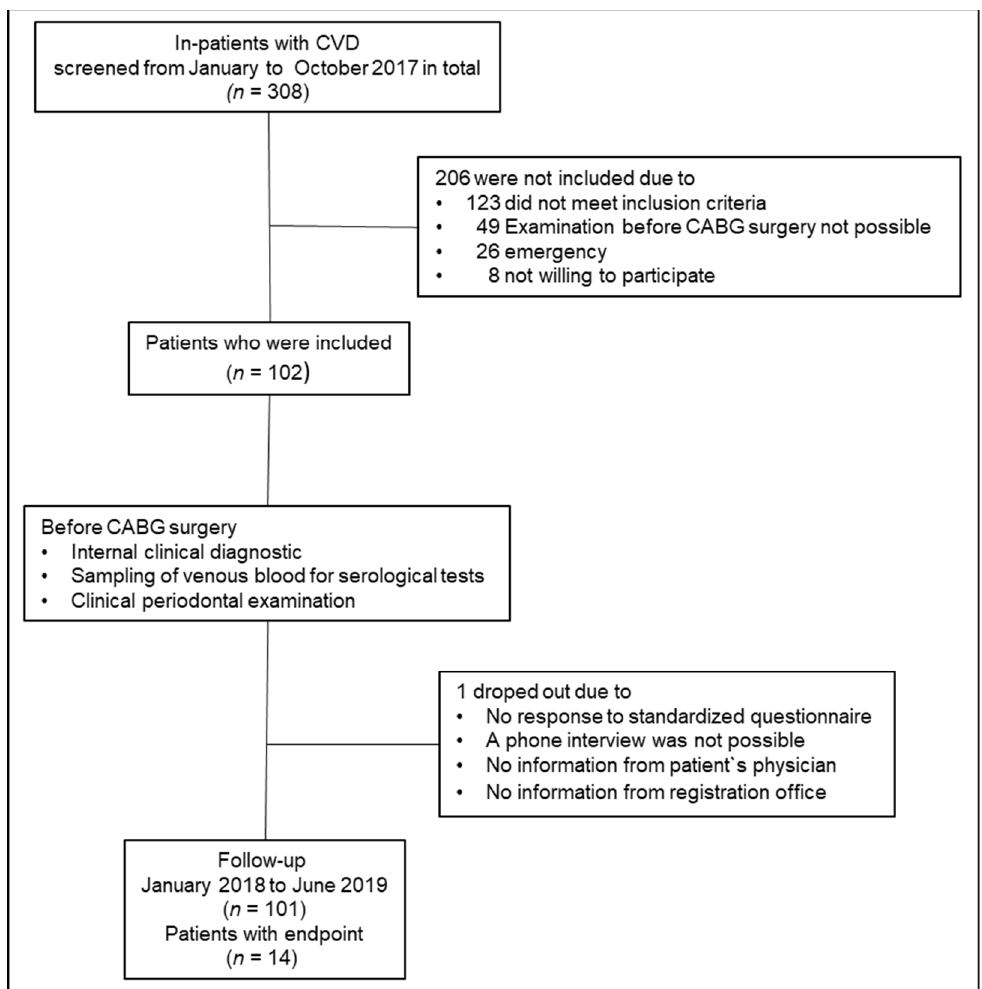
Figure 1. Study design flow chart.